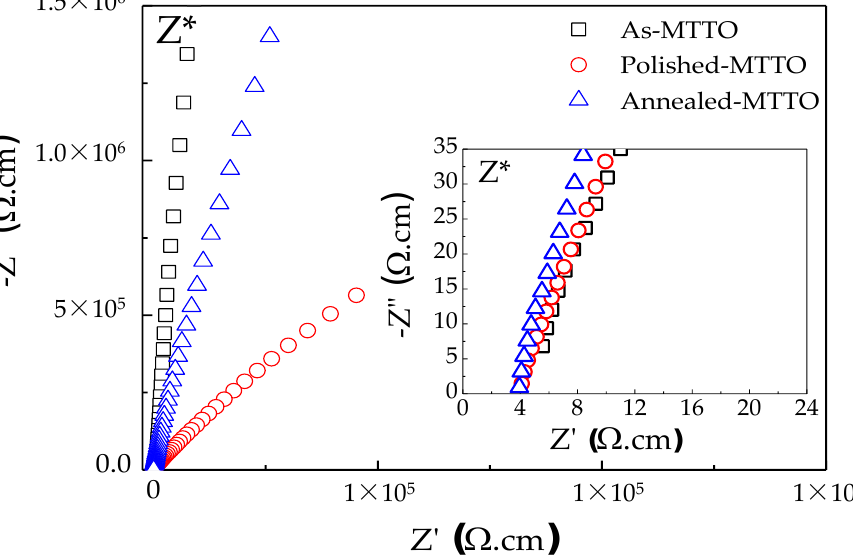
Figure 5. Impedance complex plane plots (Z*) for the as-MTTO, polished MTTO, and annealed MTTO ceramics at RT. The inset shows Z* plots of the high frequency data near the origin.